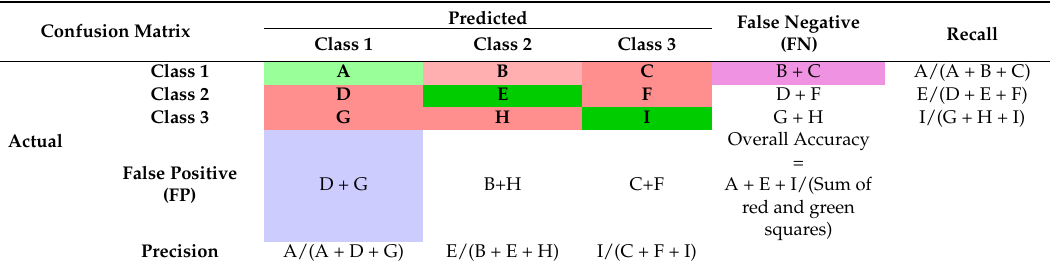
Table 8. Computing different performance measures from Confusion Matrix. Precision and recall of each class is calculated.